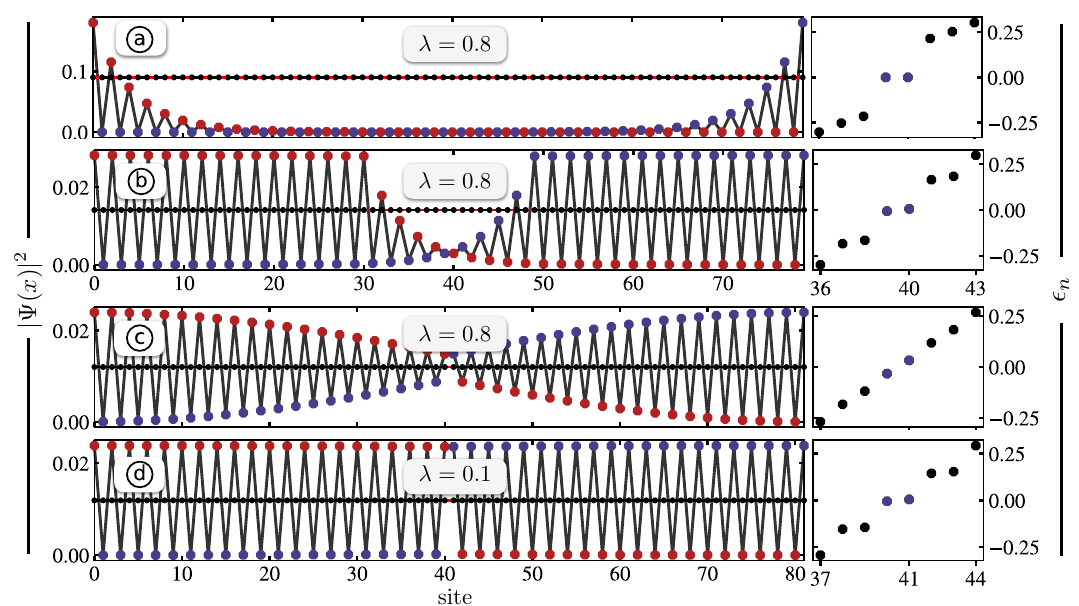
Figure 7: Modes | Ψ ( x ) | 2 in vicinity of zero energy for various tight-binding models. Values of | Ψ ( x ) | 2 are marked in an alternating fashion by red and blue dots for A and B sublattices. Each model is illustrated in the center of the left panel, with strong (weak) bonds marked by black (red) lines. Right panels show the energy spectra close to zero energy, with the two symmetric modes closest to ε = 0 marked in blue. a (cid:13) The pure SSH chain features localized zero energy modes, having support only on sublattice A (B) for the left (right) edge mode. Here, λ = 0.8. b (cid:13) An SSH impurity of length 20 attached to two leads of size 30 on either side, again with λ = 0.8. The long SSH impurity polarizes the wave functions close to zero energy, having support only on the A (B) sublattice on the left (right) to the extended impurity. c (cid:13) A single impurity bond with 40 metallic sites to each left and right side for λ = 0.8. d (cid:13) The same as c (cid:13) with λ =